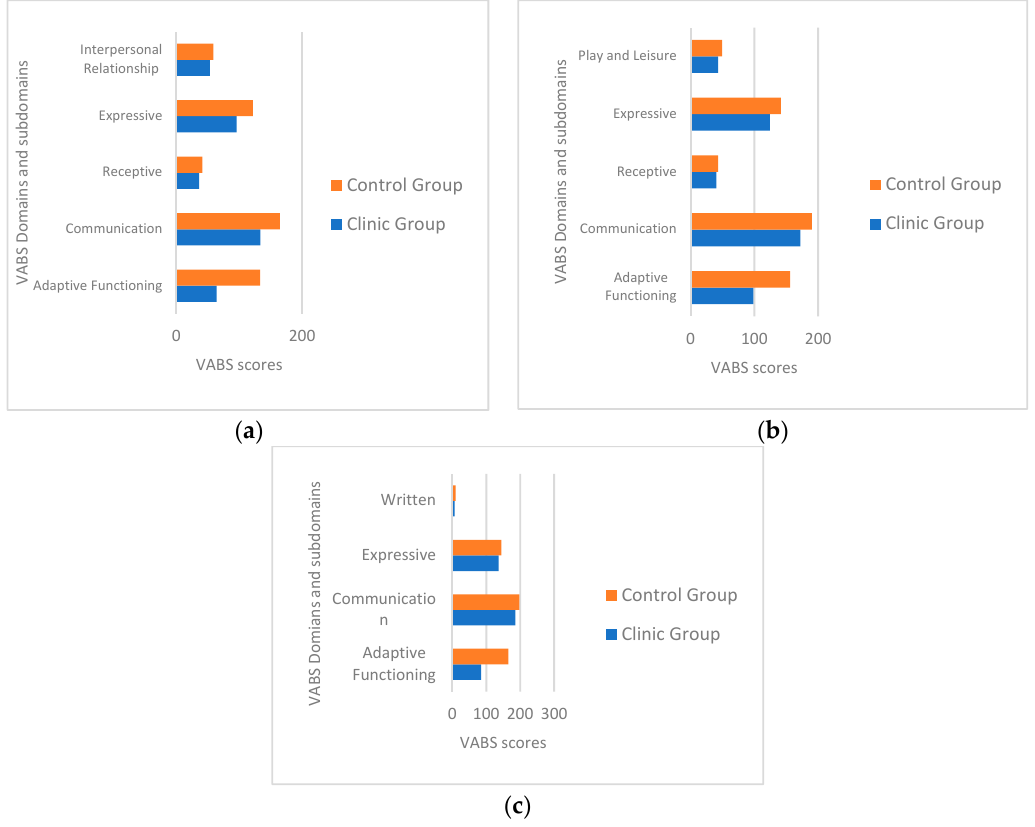
Figure 2. VABS adaptive significative functioning domain and subdomain scores comparing: ( a ) Children with leukemia aged 30–48 months one-year post-treatment and matched controls, ( b ) children with leukemia aged 49–60 months one-year post-treatment and matched controls, ( c ) children with leukemia aged 61–71 months one-year post-treatment and matched controls.